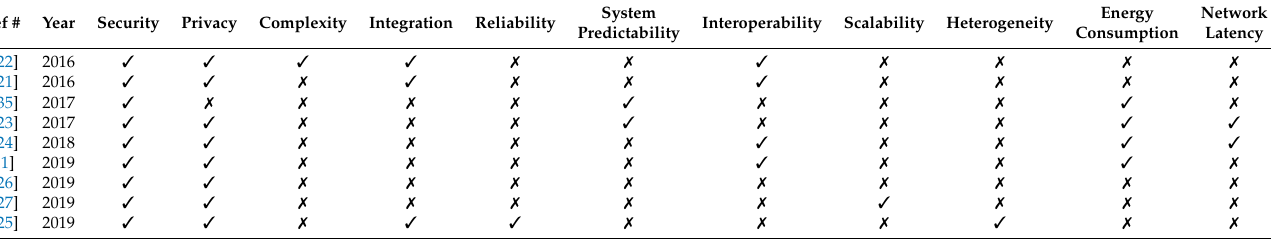
Table 16. Comparison of the existing evaluation factors in the Smart cardiac